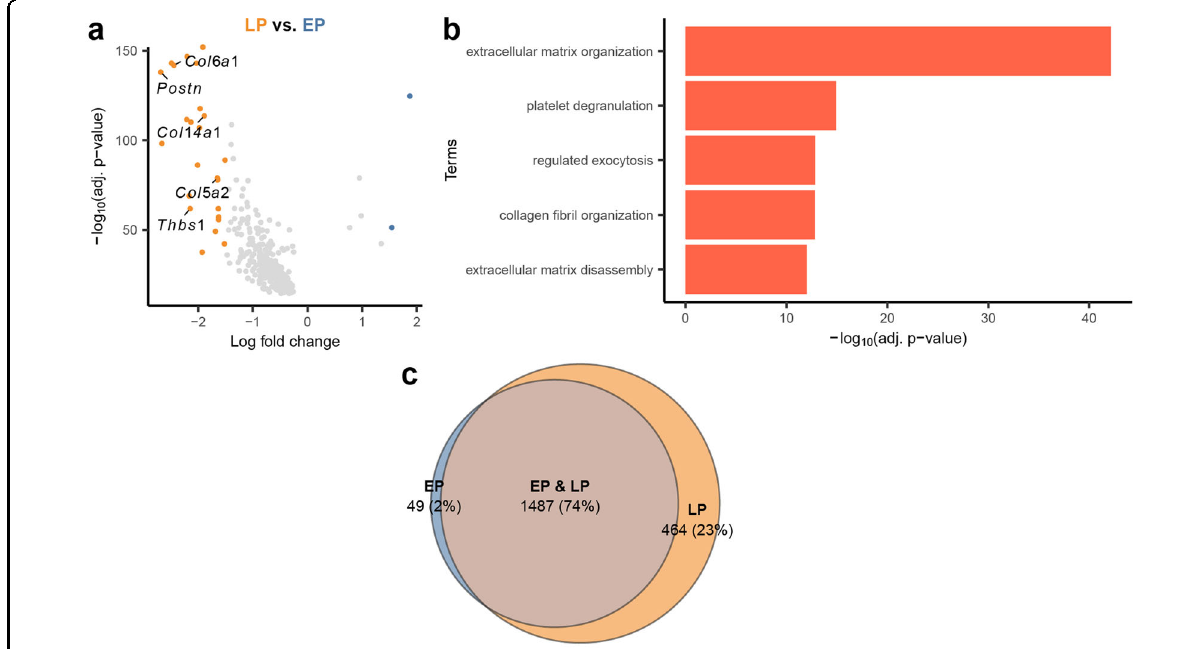
Fig. 3 Differential expression analysis and enriched gene ontology between LP and EP. a Volcano plot of DEGs between LP and EP. ECM- related genes such as thrombospondin, periostin, and collagens are shown on plot. Genes with adjusted P -value < 0.1 were colored by orange (log- fold change > 1) or blue (log-fold change < – 1), whereas ≥ 0.1 were colored as gray. b Bar plot of gene ontology terms enriched with DE genes of LP (log-fold change > 0). c Venn diagram of highly variable gene sets between EP and LP. Highly variable genes between two populations were selected. Genes with raw counts > 3 were kept as set in the